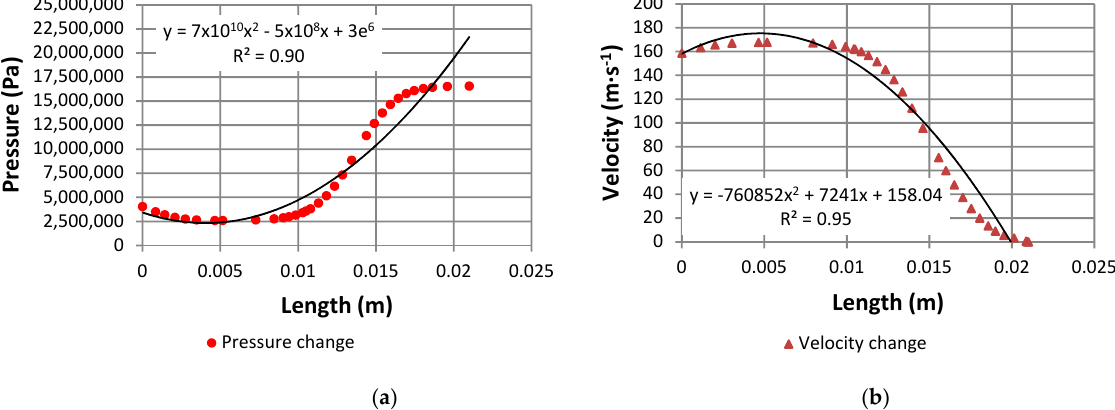
Figure 11. The variation curves of pressure ( p ) ( a ) and velocity ( υ ) ( b ) for a 0.0033 m 3 · s − 1 volume flow rate (200 L · min − 1 ).